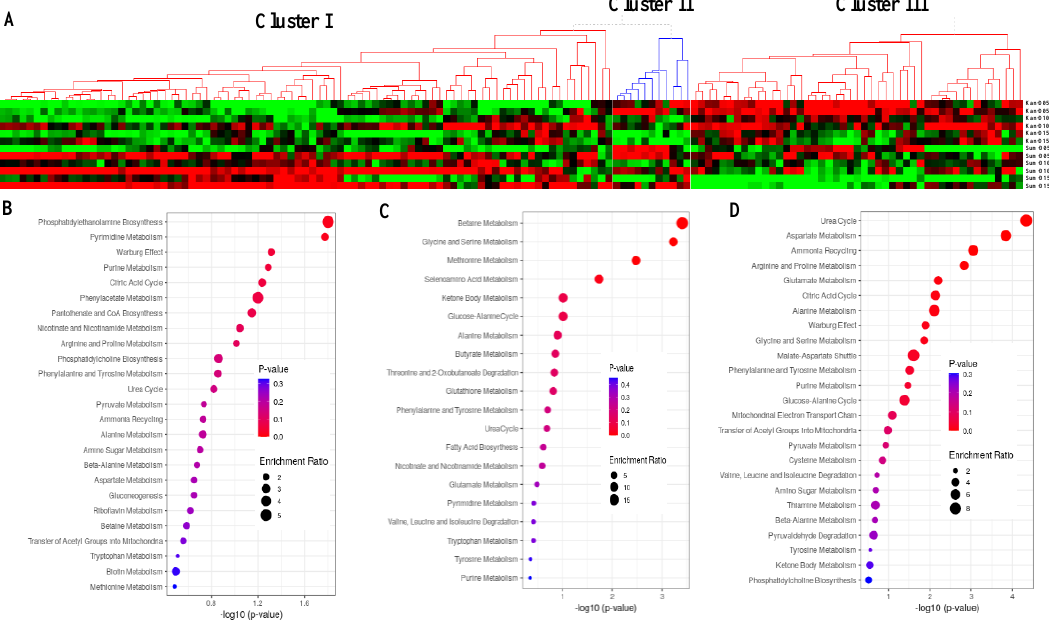
Figure 2. Clustering of the di ff erent metabolites enriched in infested and control plants. ( A ) Expression values are given in log 2 (value + 1) with z-score normalization. Green below the average. Red above the average. The values are provided in Supplemental Table S1. ( B ) Enrichment of the metabolites for the Cluster I. ( C ) Enrichment of the metabolites for the Cluster II. ( D ) Enrichment of the metabolites for the Cluster III.